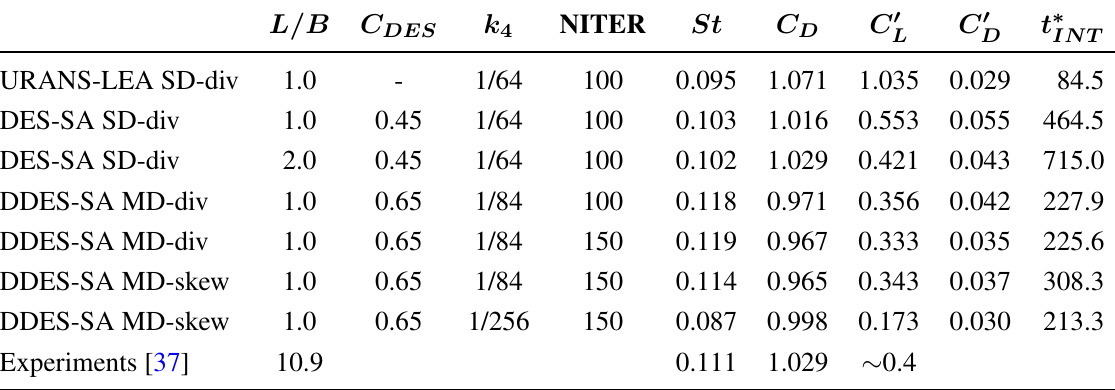
Table 2. Strouhal number and mean ( C rectangular 5:1 cylinder. t ∗ number of inner iterations per physical time step; SD, scalar artificial dissipation; div, divergence; SA, Spalart–Allmaras; DDES, delayed DES; MD, matrix artificial